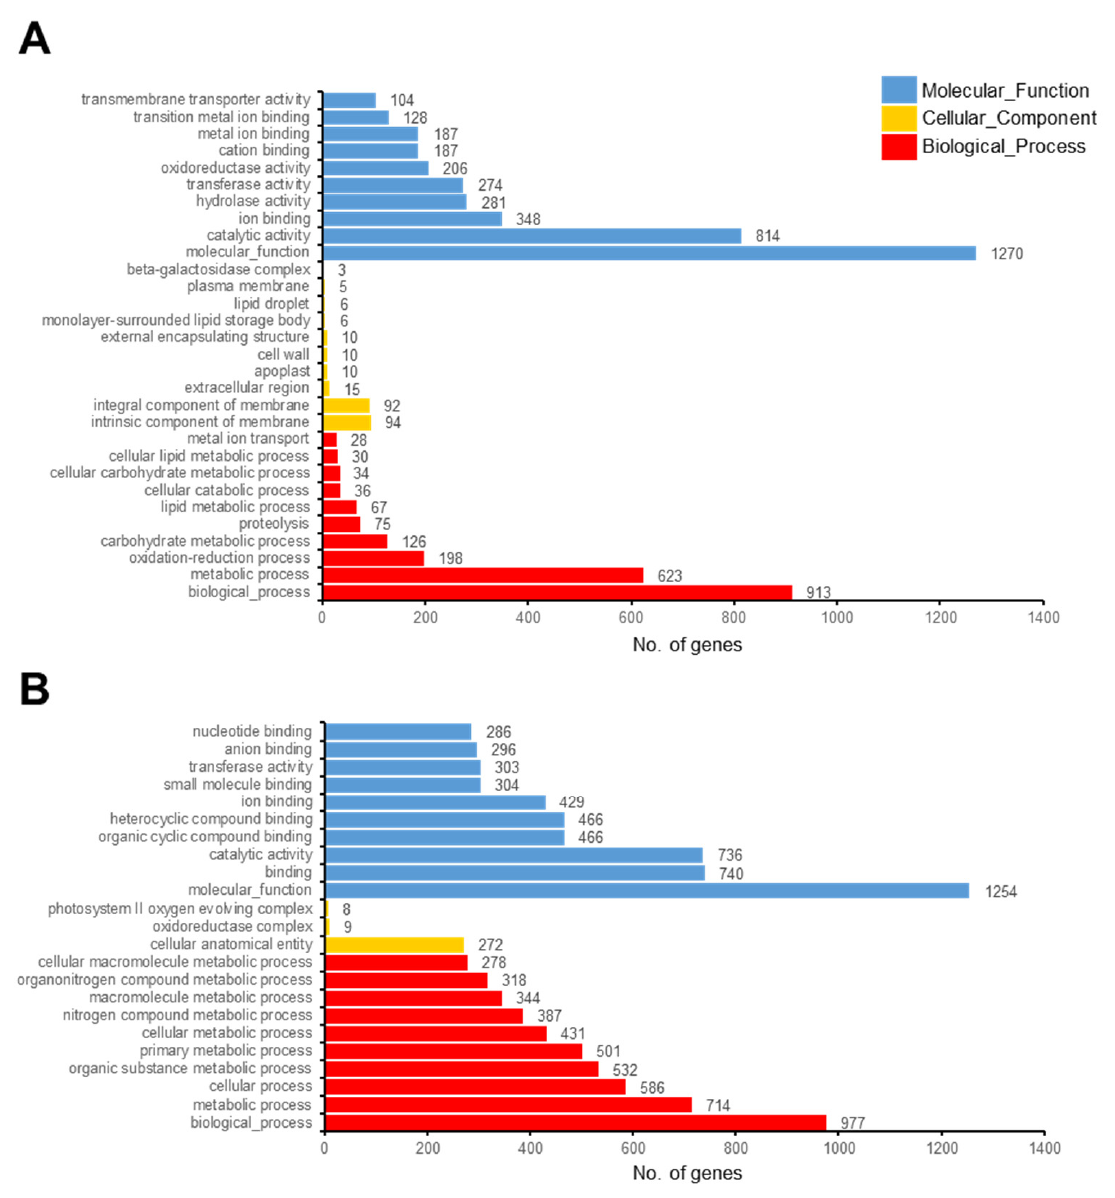
Figure 4. Functional categories of upregulated ( A ) and downregulated ( B ) genes in drought-treated garlic leaves. Top 10 biological process, cell component, and molecular function pathways are displayed.